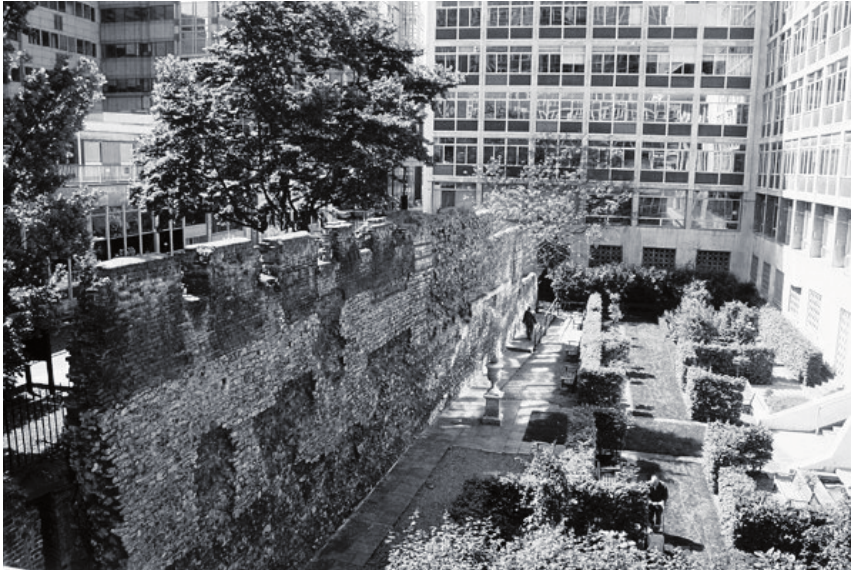
Figure 1. City Wall, St. Alphage´s Churchyard, London (Photo by C.